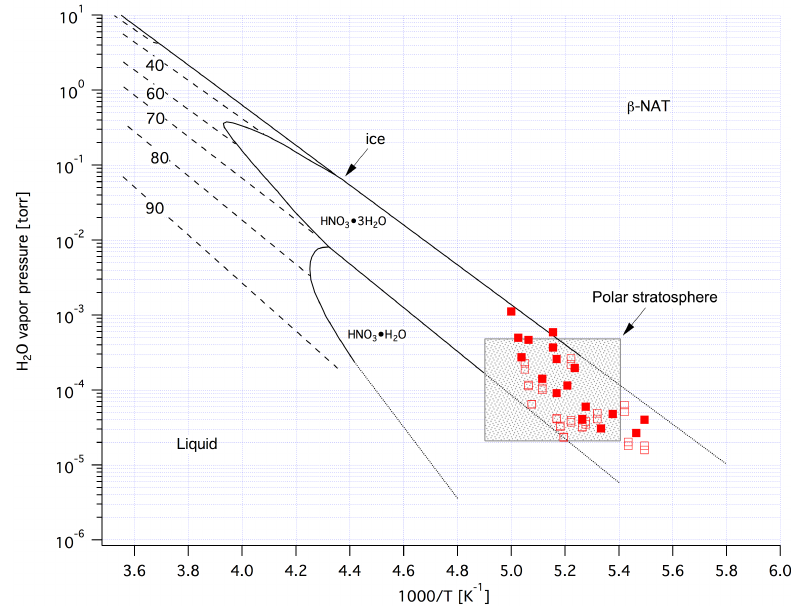
Figure 5. Binary phase diagram of the HNO 3 / H 2 O system reconstructed from McElroy et al. (1986), Hamill et al. (1988), and Molina (1994). The full symbols represent calculated values of P eq (H 2 O) for β -NAT using the kinetic data of PV experiments. Empty circles represent calculated values of P eq (H 2 O) using the kinetic data of TO (Two-Orifice) experiments. The solid lines represent the coexistence conditions for two phases and the dashed lines represent vapor pressures of liquids with composition given as % ( w/w ) of HNO 3 . The shaded gray area represents polar stratospheric conditions. Table 3. Peak Positions in cm − 1 in the mid-IR of HNO 3 and HNO 3 / HCl hydrates a . α -NAT / HCl β -NAT / HCl α this work this work